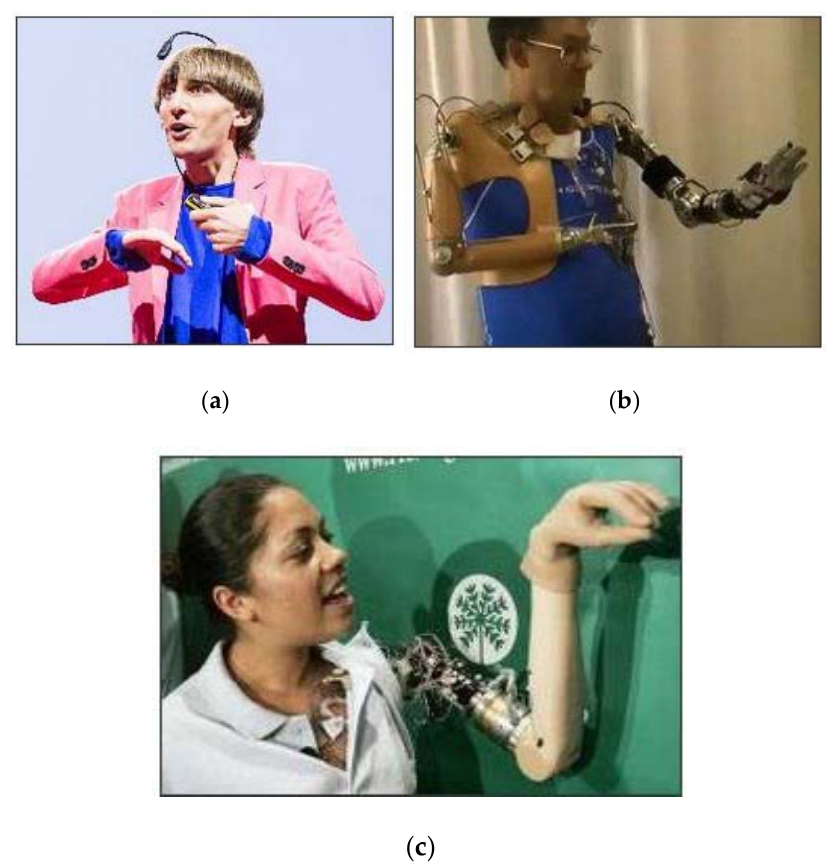
Figure 10. Examples of human cyborgs. ( a ) Neil Harbinson, ( b ) Jesse Sullivan, ( c ) Claudia Mitchell. Source: www.medicalfuturist.com